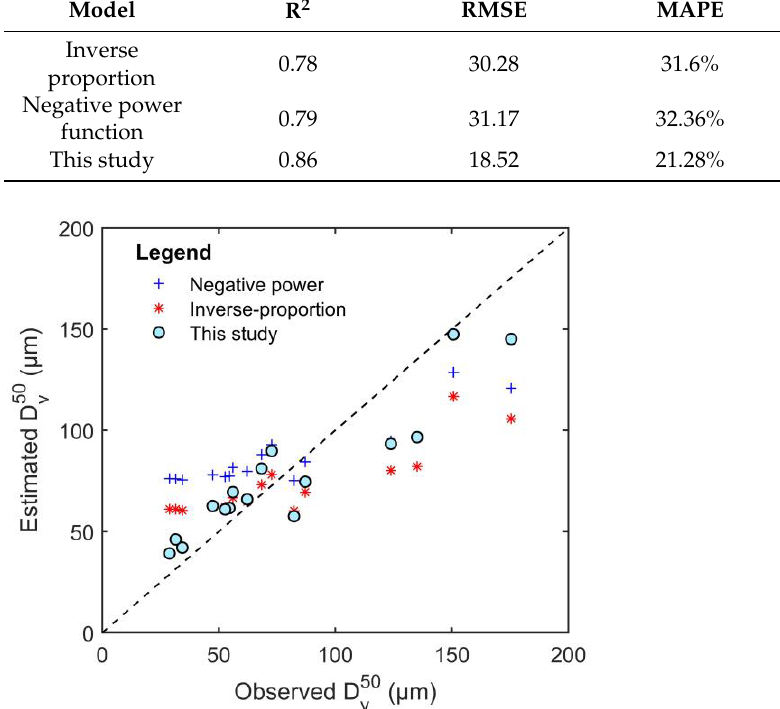
Figure 6. Validation of the D v50 retrieval models proposed by previous studies and developed in this study. this Table 4. Performance comparison of Dv50 models reported by previous studies and that proposed in this study in validation.